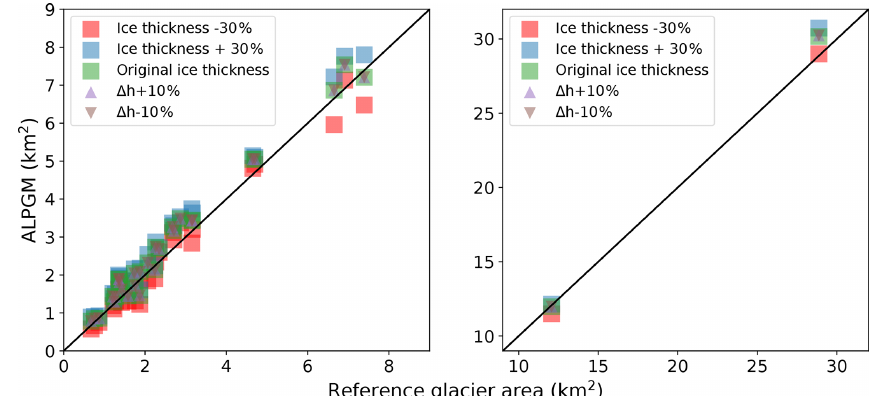
Figure 11. Simulated glacier areas for the 2003–2015 period for the 32 study glaciers using a deep learning SMB model without weights. Squares indicate the different F19 initial ice thicknesses used, taking into account their uncertainties, and triangles indicate the uncertainties linked to the glacier-specific geometry update functions. For better visualization, the figure is split into two, with the two largest French glaciers on the